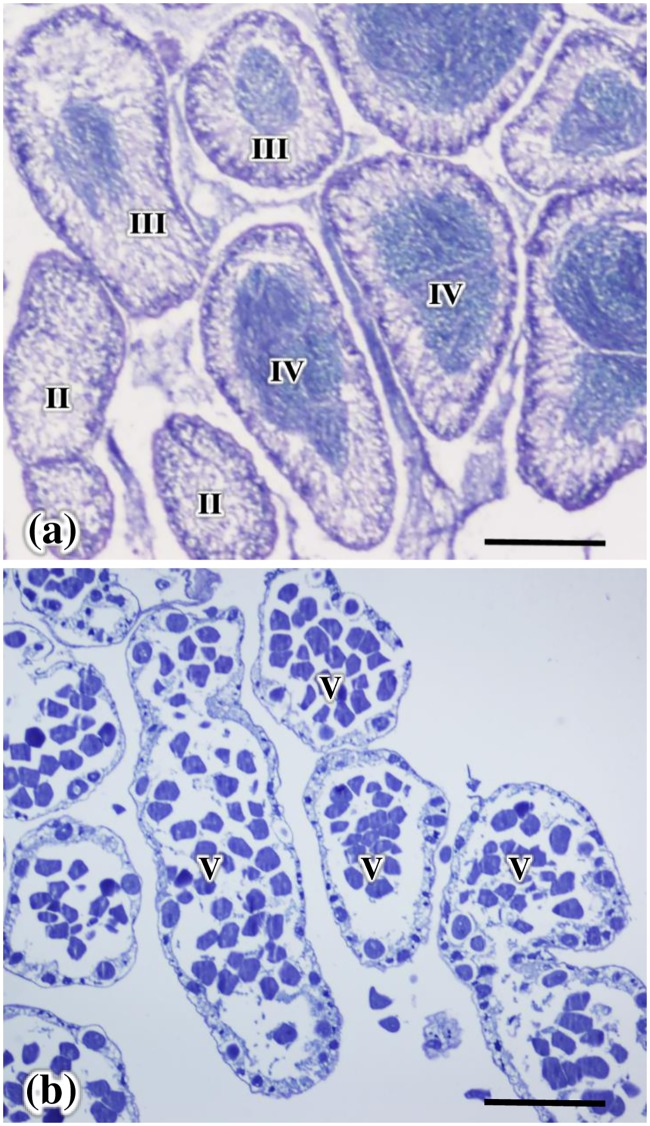
Histology of a testis (a) and ovary (b) with different development stages of acini in Heliocidaris crassispina.Scale bars represent 500 μm.